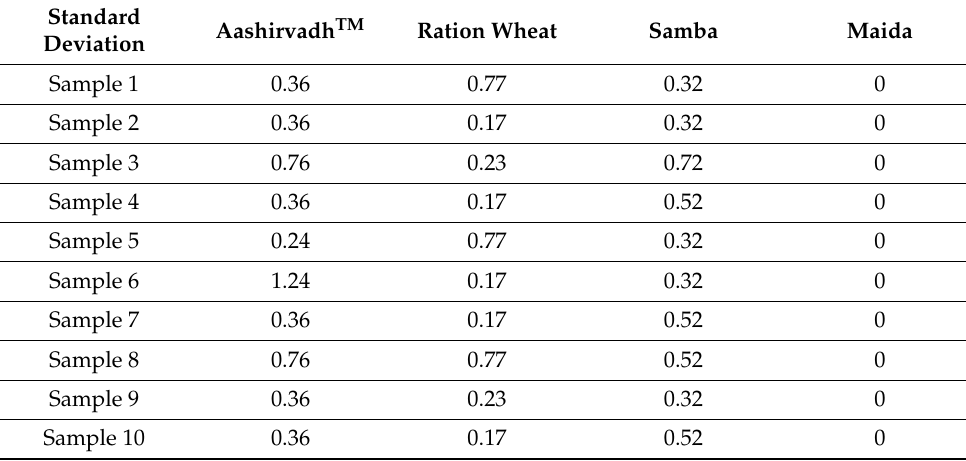
Table 4. Attenuation constant of different varieties of wheat